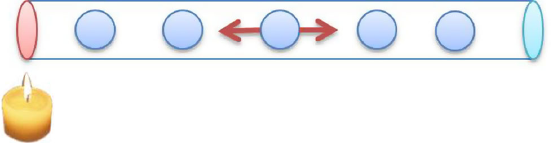
FIG. 1. Heat conduction (schematically) in a one-dimensional hollow